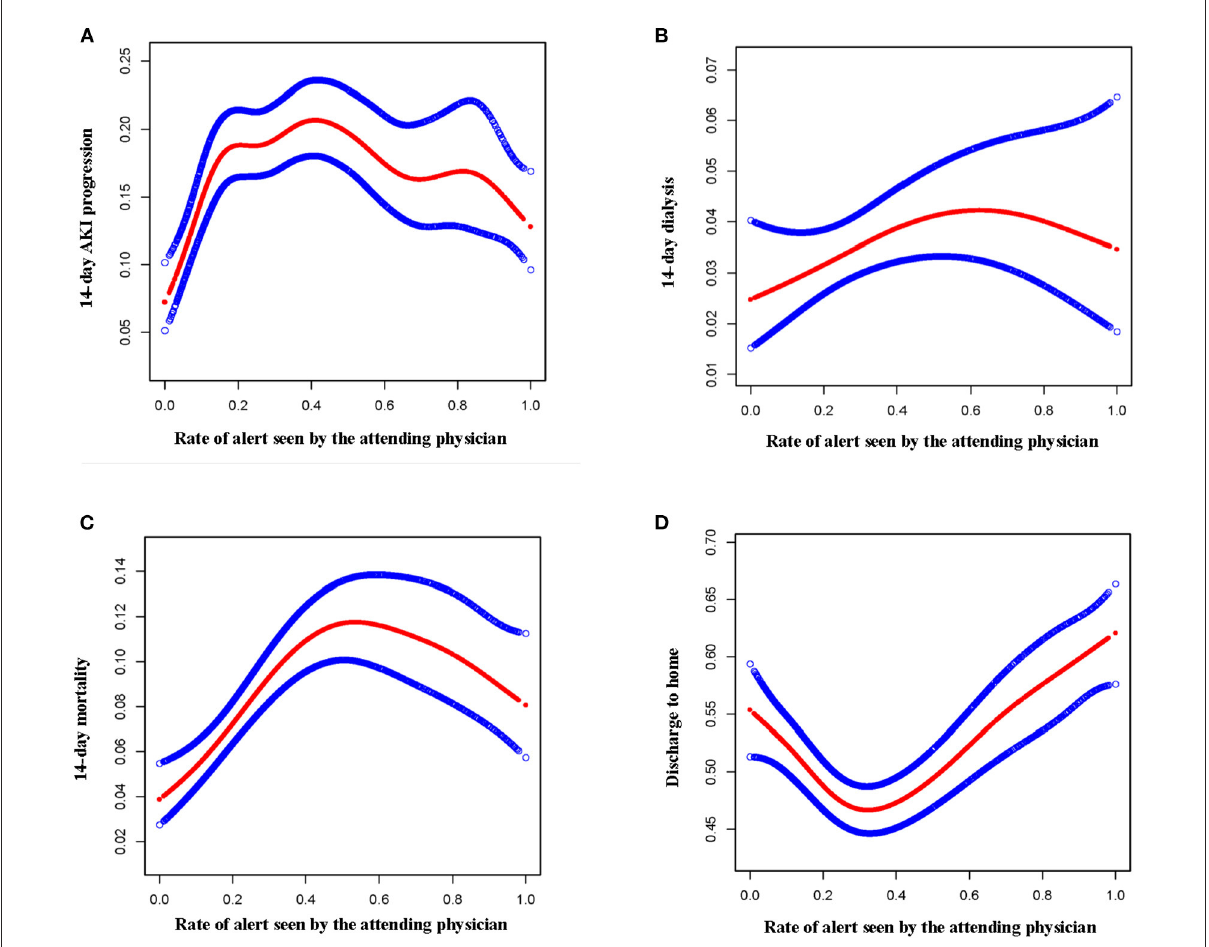
FIGURE1 The results of curve fitting analysis. (A) The relationship between alert seen by attending physician and 14-day AKI progression. (B) The relationship between alert seen by attending physician and 14-day dialysis. (C) The relationship between alert seen by attending physician and 14-day mortality. (D) The relationship between alert seen by attending physician and the discharge to